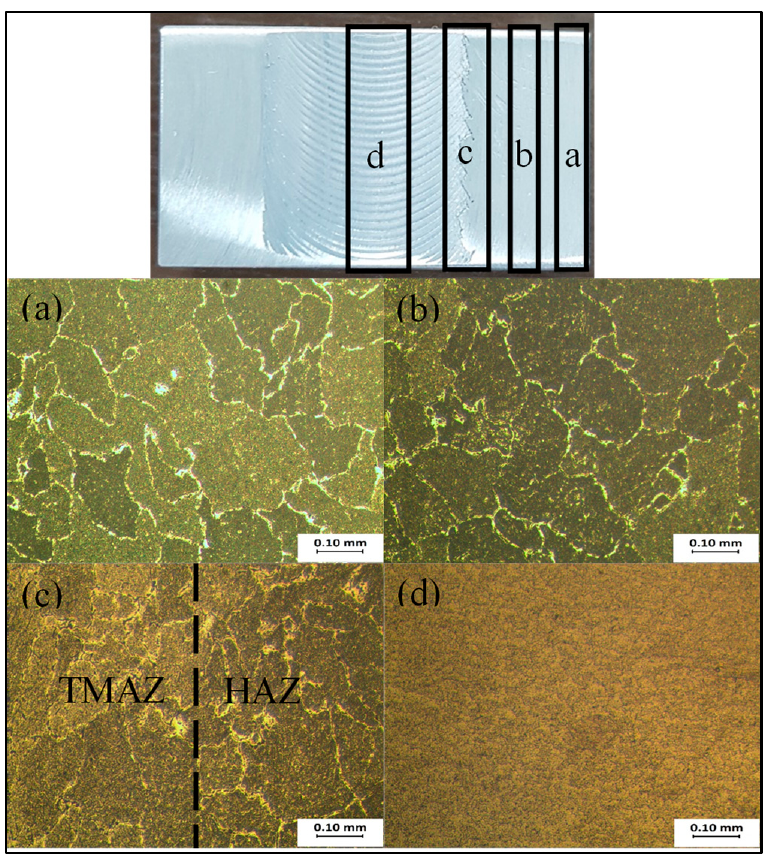
Figure 6. Microstructure of FSPed Sample 2 (10×), ( a ) base metal, ( b ) heat-affected zone (HAZ), ( c ) intersection of the heat-affected zone (HAZ), and thermo-mechanical affected zone (TMAZ) and ( d ) stir zone.